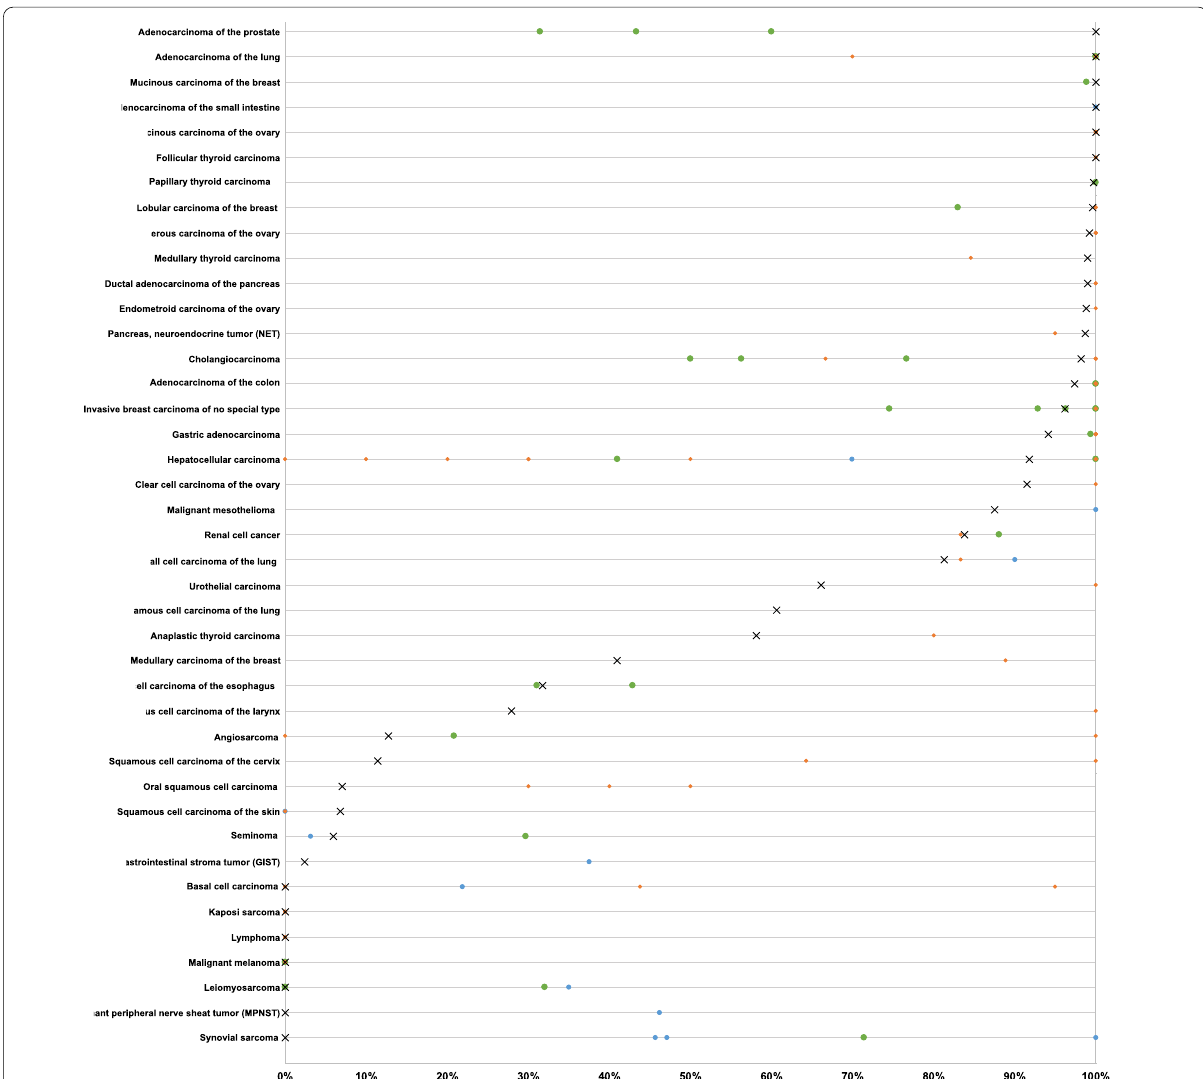
Fig. 5 Graphical comparison of Cytokeratin 18 (CK18) data from this study (x) in comparison with the previous literature. Orange dots are used for studies involving 20 cases, green dots are used for studies > 20 cases, blue dots are from Chu and Weiss 2002 (Review) (Chu and Weiss 2002). All ≤ studies are quoted in the list of